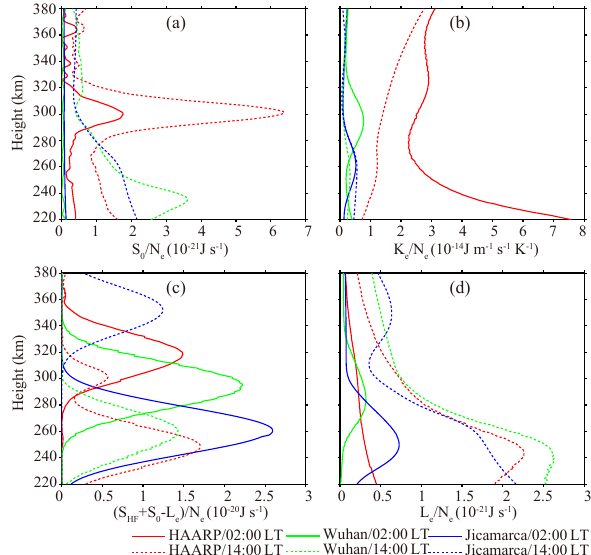
Figure 6. (a) The steady-state source term S 0 profile per electron; (b – d) profiles of the parallel coefficient of thermal conductivity K e , the total electron heating rate S HF + S 0 − L e and the electron cool- ing rate L e per electron at heating time of 1.0s with modulation frequency of